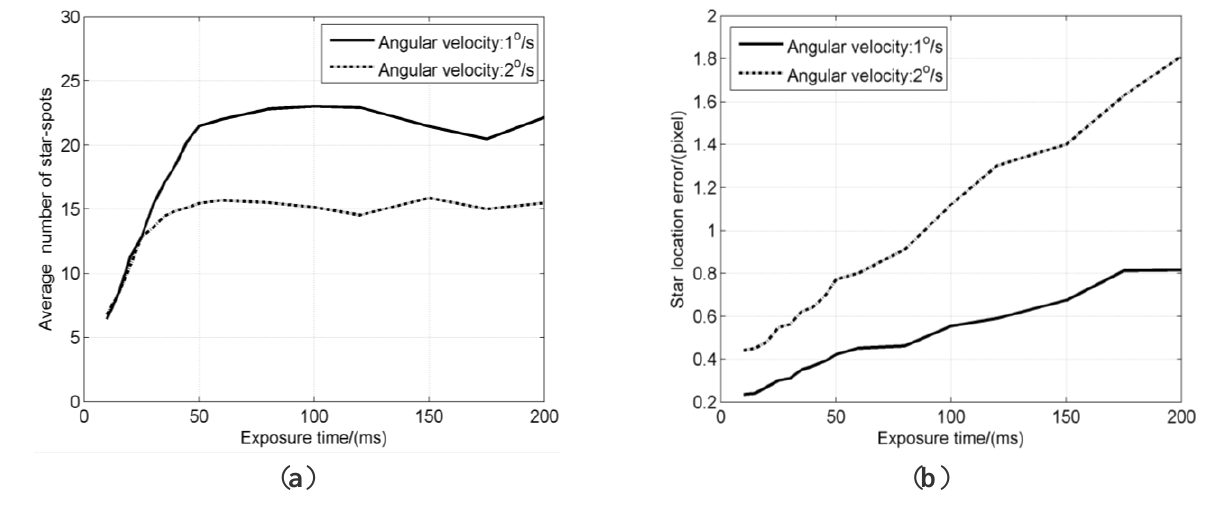
Figure 10. ( a ) The average number of the star-spots; ( b ) The average star location error with different exposure times in the